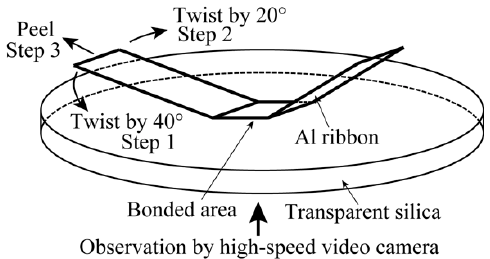
Figure 1. Schematic illustration of ultrasonic bonding apparatus and in-situ observation system. Figure 2. Schematic illustration of twist and peel test of Al ribbon bonded on silica substrate.